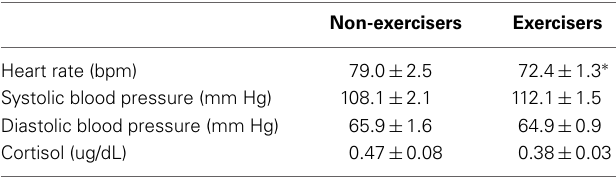
Table 2 | Baseline values of physiological measures.